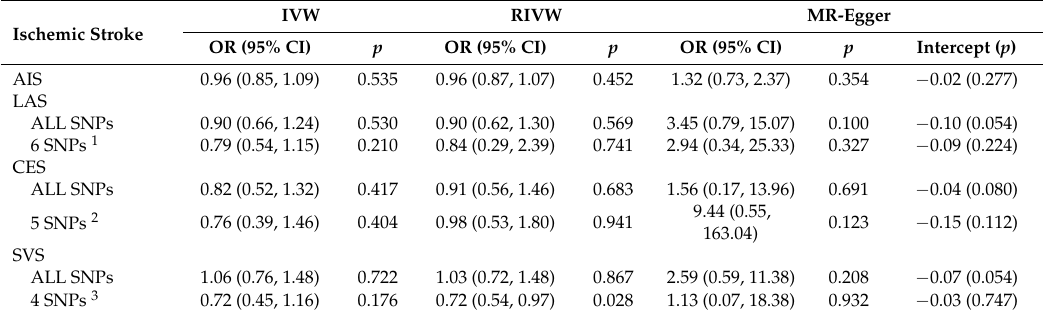
Table 2. Odds ratios for the association between TL and IS and its subtypes using different methodological approaches and exclusions for pleiotropic